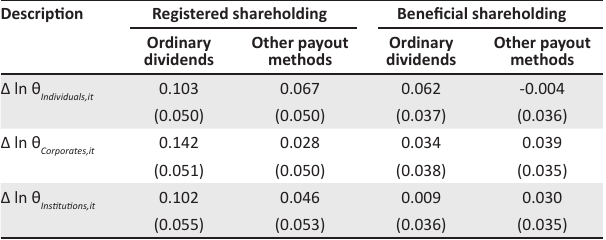
TABLE 3: Standardised beta coefficients and errors of investor tax preferences